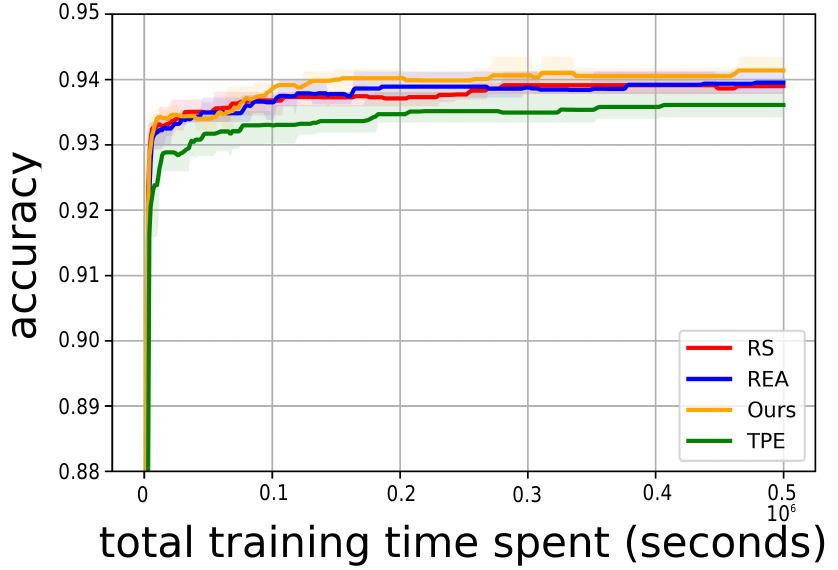
Figure 3. Compare the mean test accuracy along with error bars on NAS-Bench-101. Figure 3. Comparison of the mean test accuracy along with error bars on NAS-Bench-101.